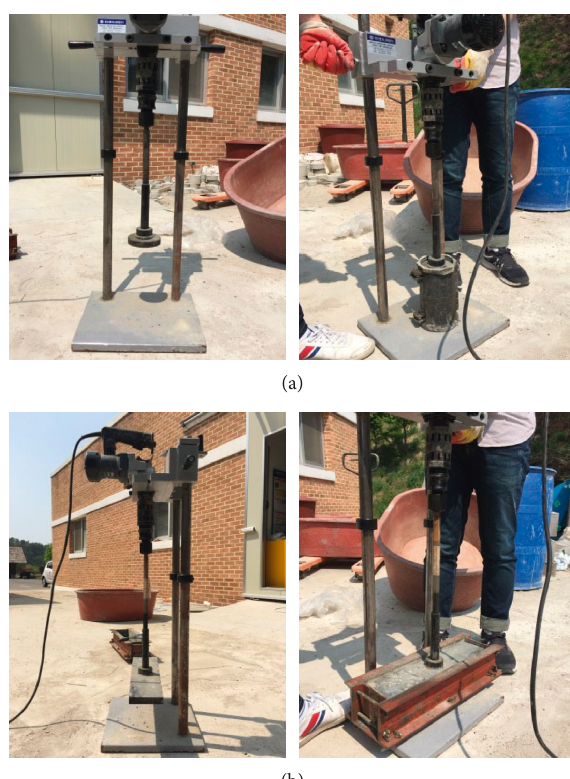
Figure 2: Manufacturing of test specimens [16]. (a) Manufacturing of compressive strength specimens. (b) Manufacturing of flexural strength specimens.